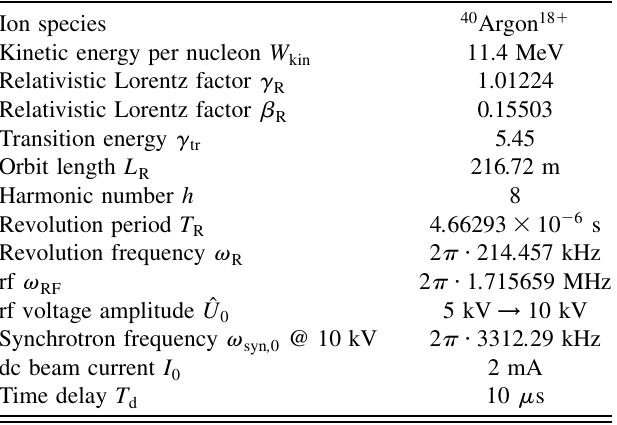
TABLE I. Parameters for simulation and experiment.